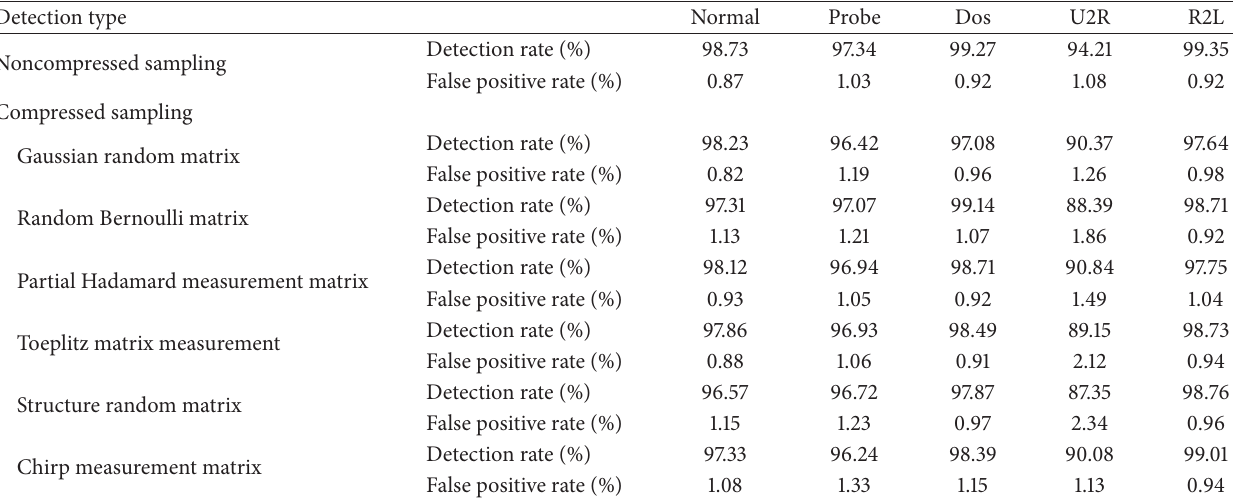
Table 1: Detection result of the support vector machine (SVM) as the